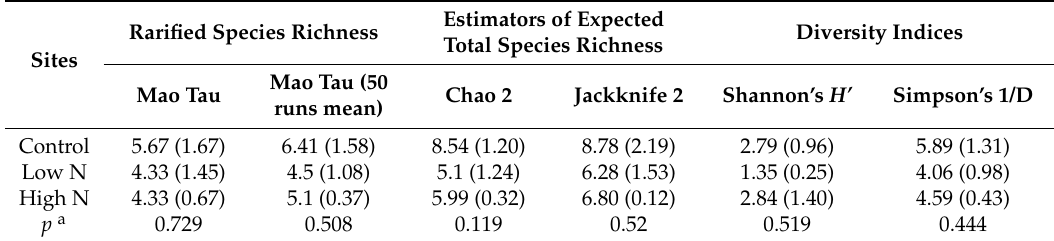
Table 3. Estimators of operational taxonomic unit (OTU) richness and diversity of ECM fungi in different treatments. Data represents mean with the standard error in parentheses per plot; n = 3 (3).